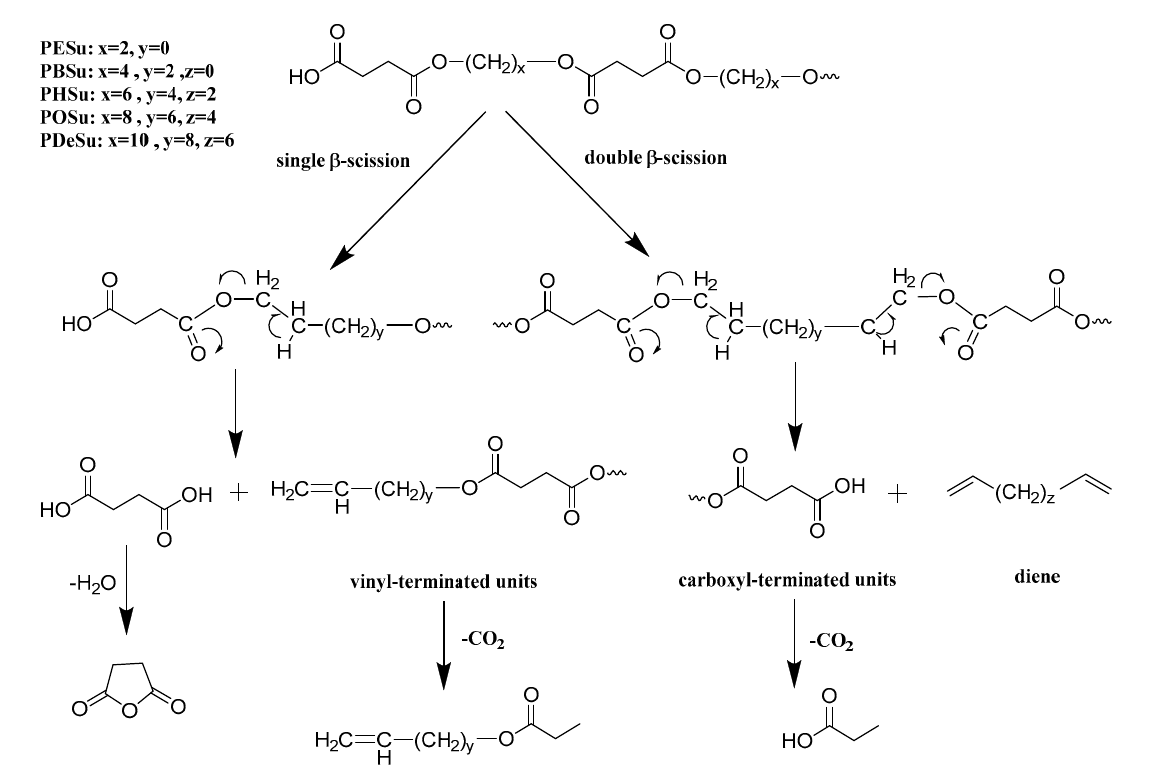
Scheme 3. β− scission decomposition mechanism of poly(alkylene